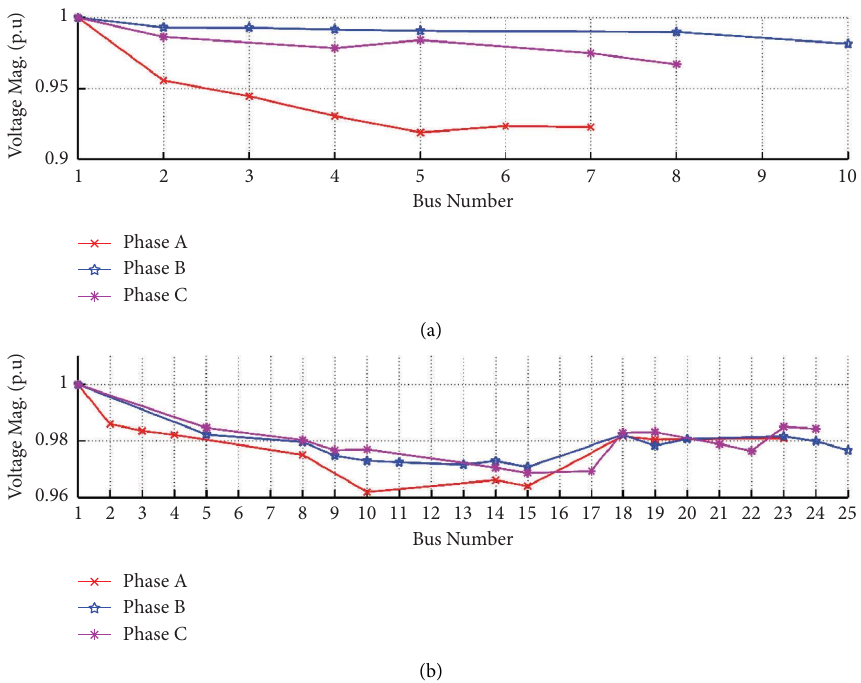
Figure 8: Voltage magnitude of (a) 10-bus and (b) 25-bus unbalanced distribution system. Table 5: Comparison of iterations of the balanced 33-bus weakly meshed system. Proposed method FFDWMP (Algorithm No. of meshed in 33-bus system